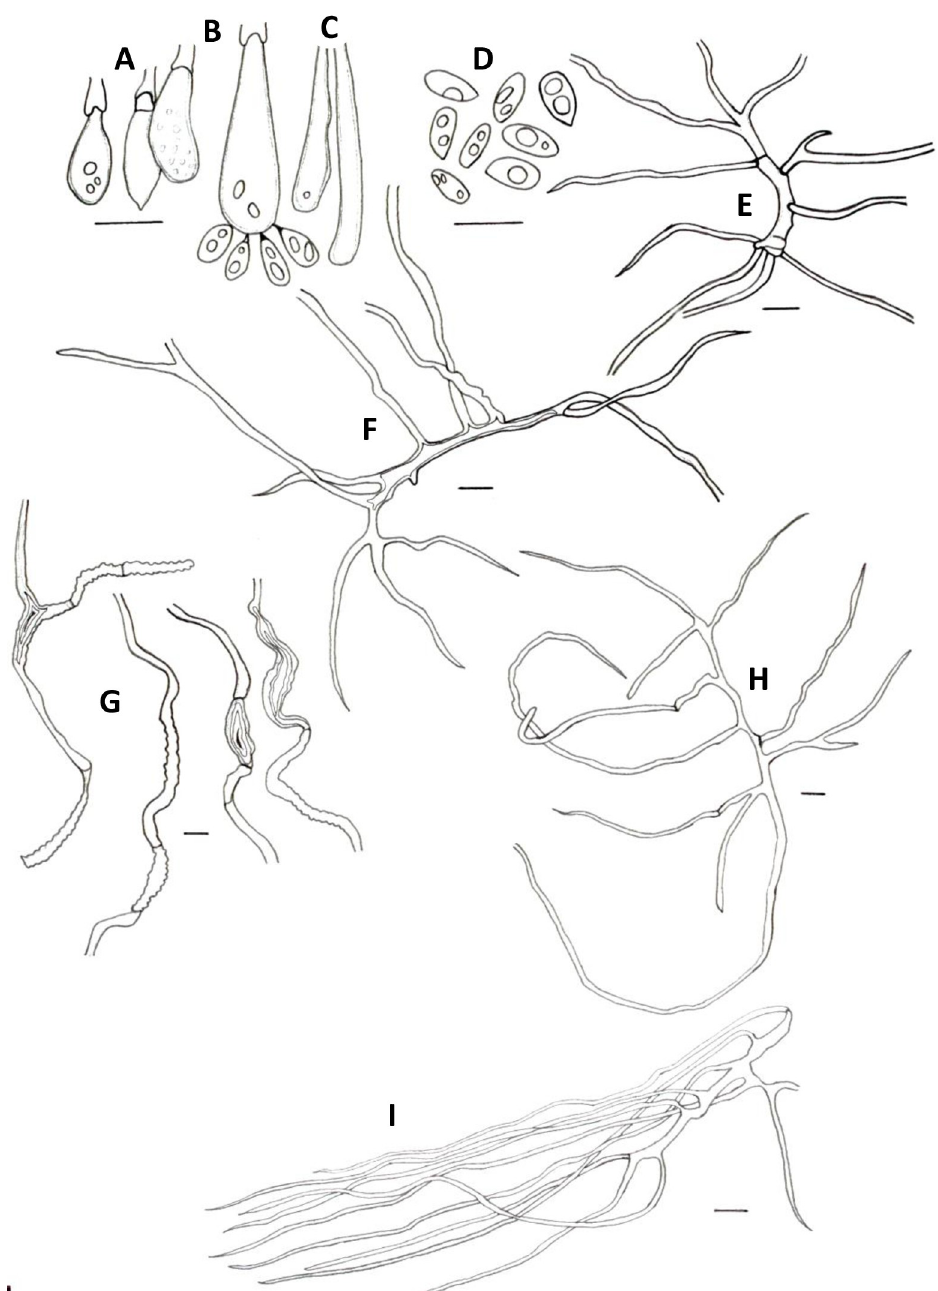
Fig 6. Microscopical features of A . tagaeri . A. Basidioles. B. Basidium. C. Hyphidia. D. Basidiospores. E-F Hyphae from trama. E. Generative hyphae. F. Skeletal-binding hyphae G-H. Hyphae from context. G. Plectenchymatous thickenings. H. Skeletal-binding hyphae. I. Skeletal-binding hyphae from stipe. Scale bars = 10 μ m. Hyphal system dimitic with generative and skeletal-binding hyphae. In the trama, genera- tive hyphae hyaline, highly branched with thin (2–3 μ m) and thick-walled (2–5.5 μ m) sections; simple septa and clamp connections. Thin-walled sections along branches and thick-walled sections on the main stem (Fig 6).